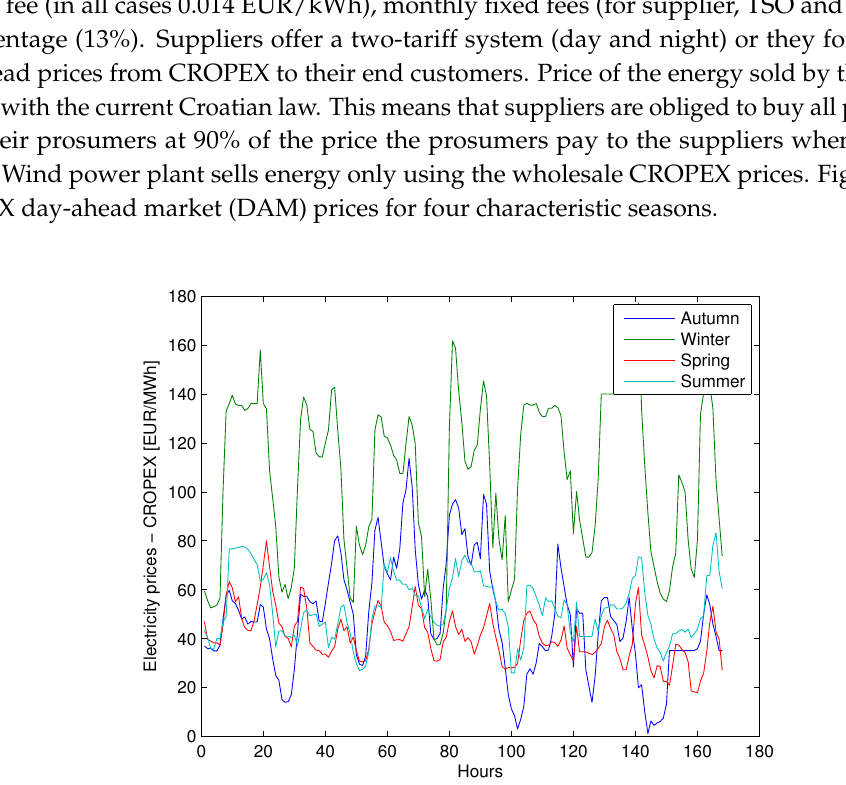
Figure 10. Weekly DAM Electricity prices for 4 representative